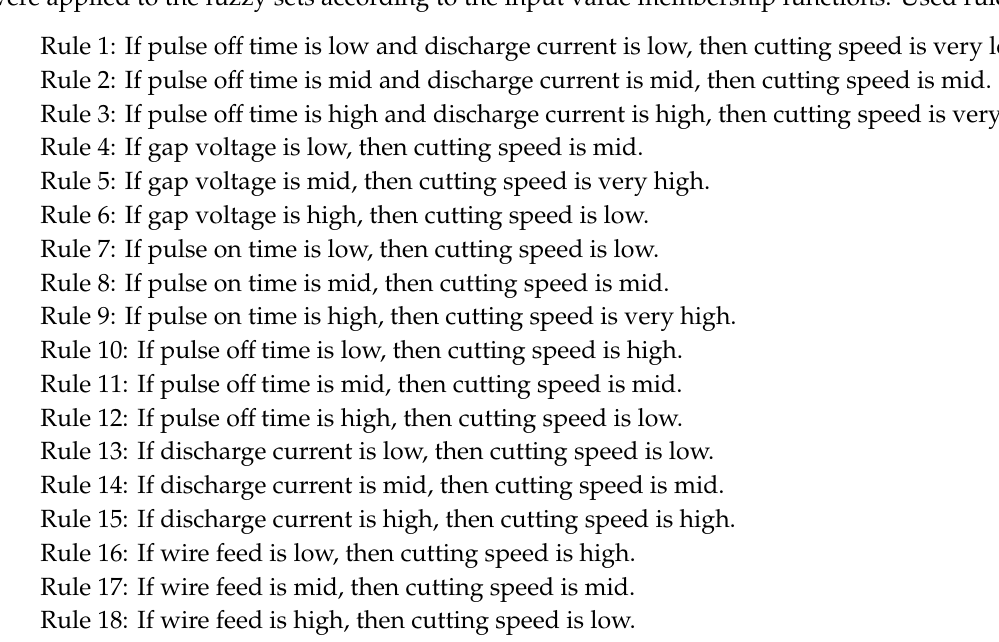
Figure 3. Membership functions of the gap voltage ( a ) and cutting speed ( b ).